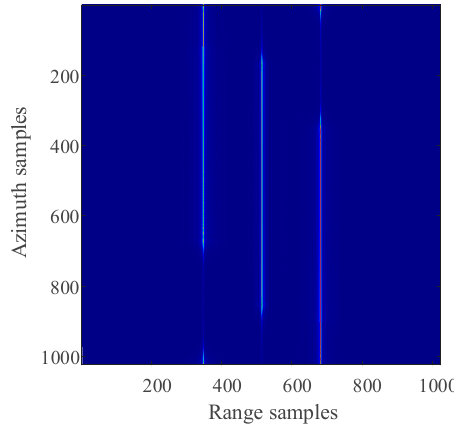
Figure 13. The result of data completion and range cell migration correction (range-Doppler do- main).